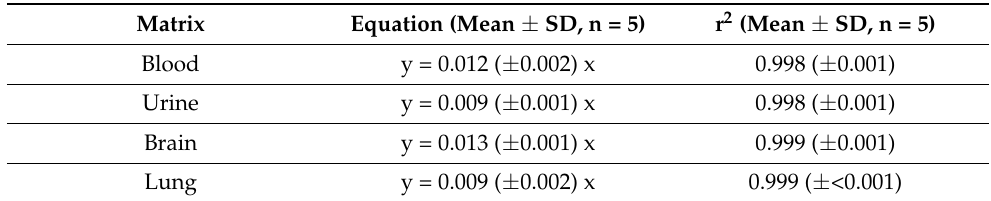
Table 1. Equations and correlation coefficients (r 2 ) for all the matrices tested are reported. Mean and standard deviation (SD) are calculated over five calibration